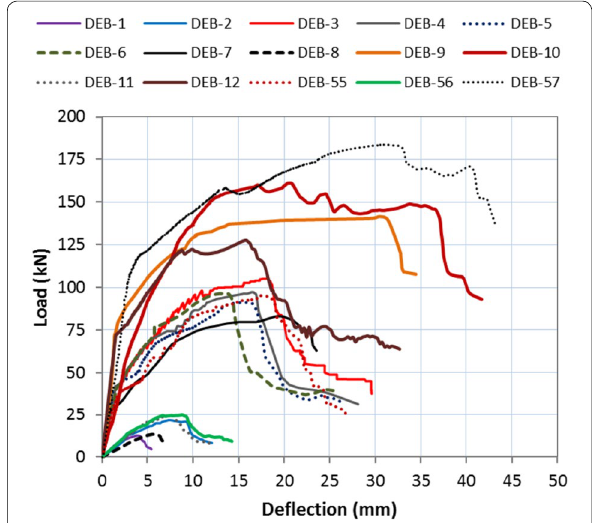
Fig. 8 The load–deflection relationship in the first group.